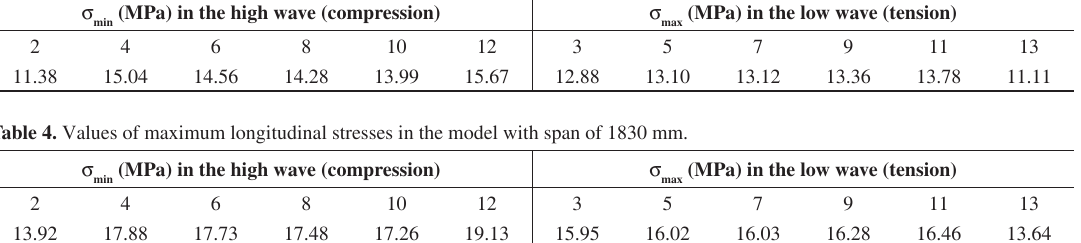
Table 3. Values of maximum longitudinal stresses in the model with span of 1530 mm. (MPa) in the high wave (compression) σ min